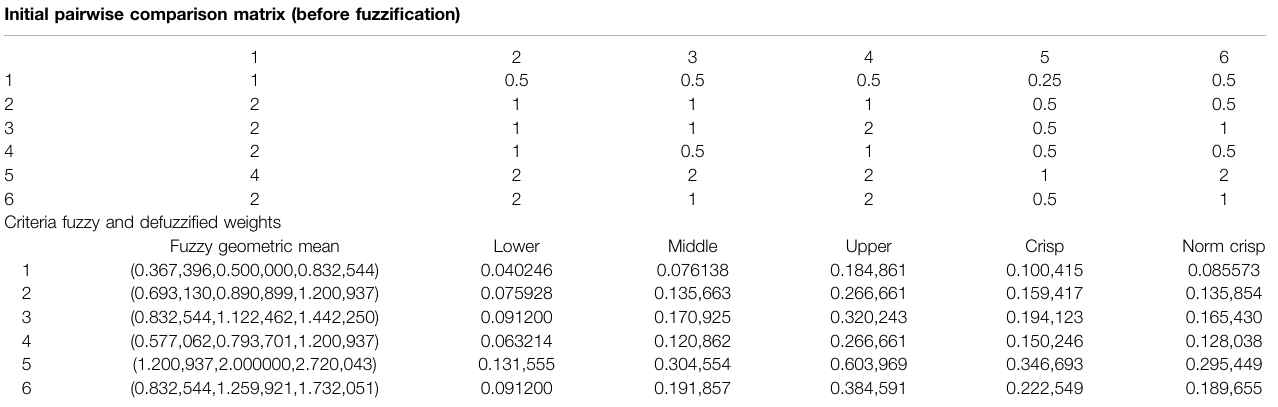
TABLE 6 | Fuzzy AHP results per criteria category – Category Social. Initial pairwise comparison matrix (before fuzzi fi